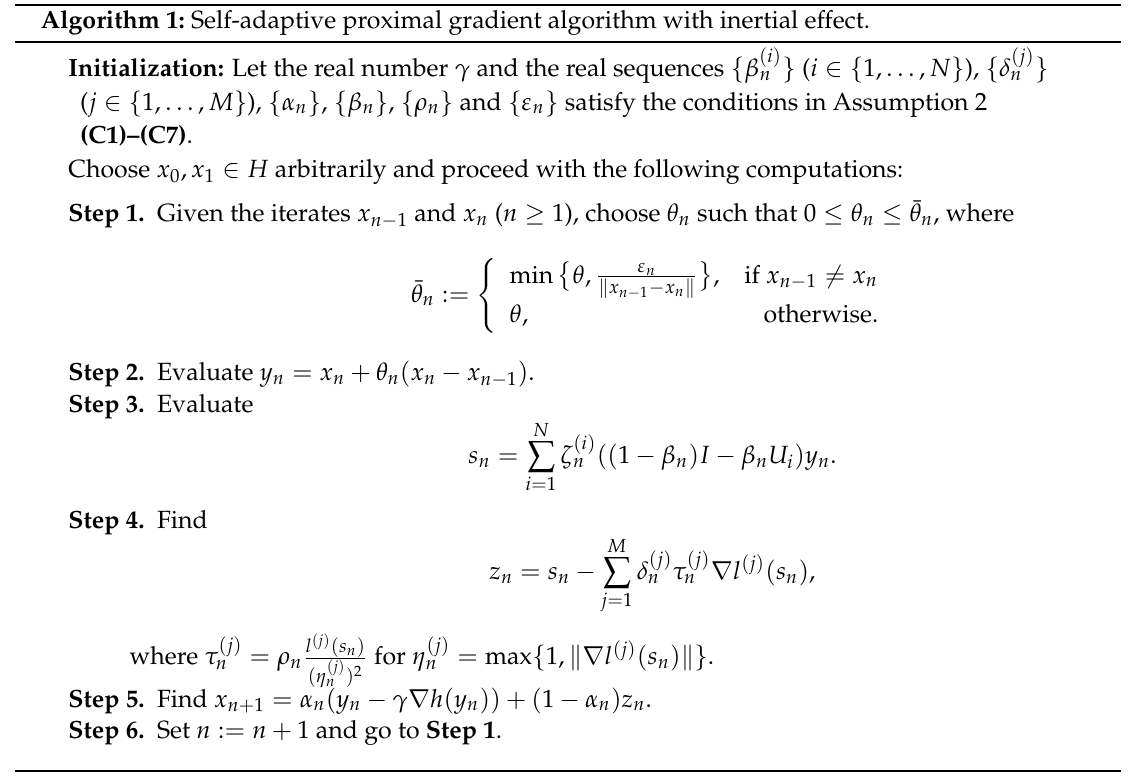
Algorithm 1: Self-adaptive proximal gradient algorithm with inertial